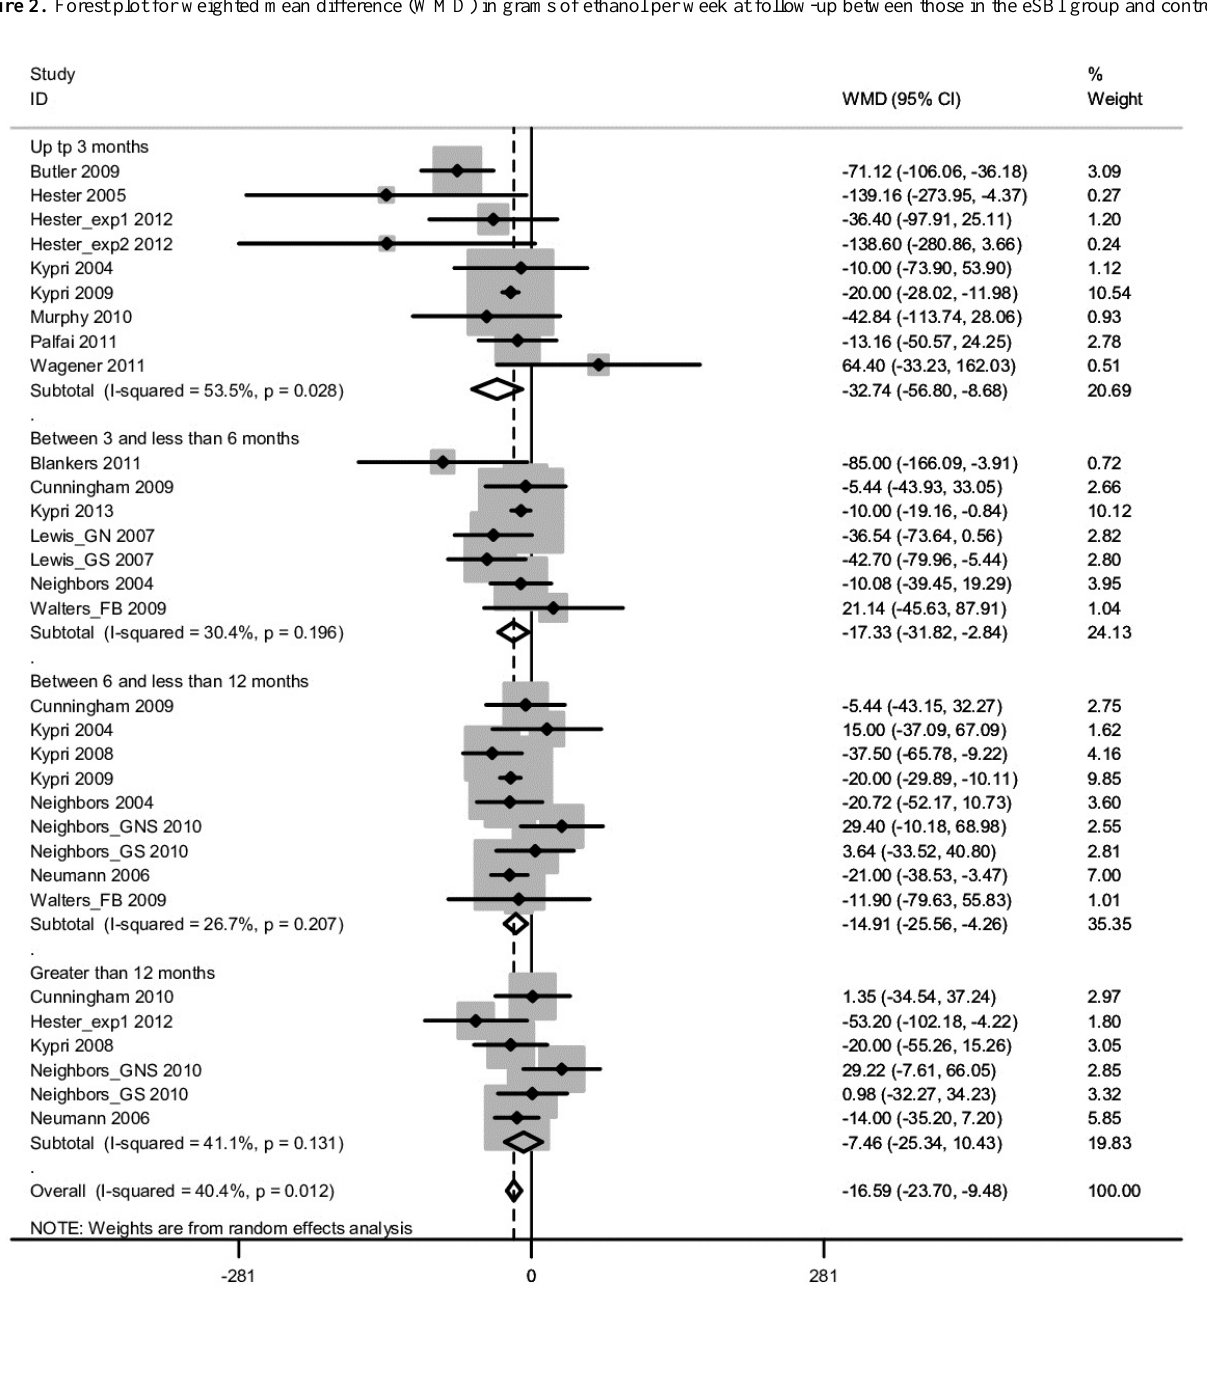
Figure 2. Forest plot for weighted mean difference (WMD) in grams of ethanol per week at follow-up between those in the eSBI group and